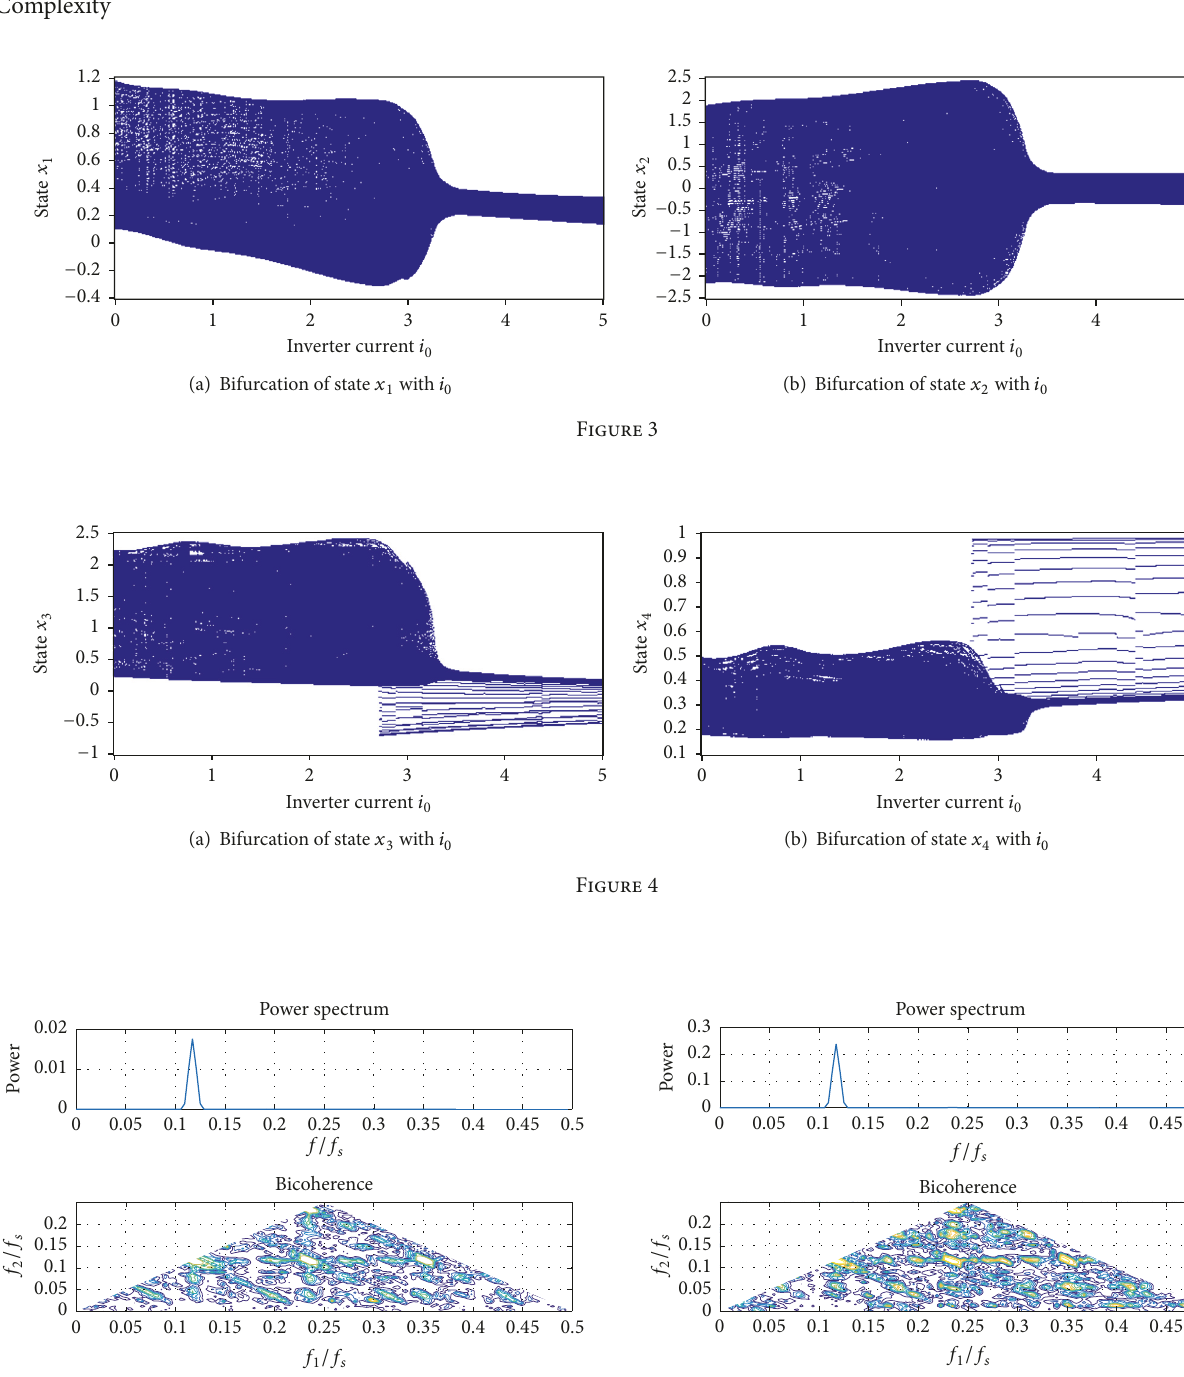
Figure 5: Contour of bicoherence of state 𝑥 for the smart grid system.